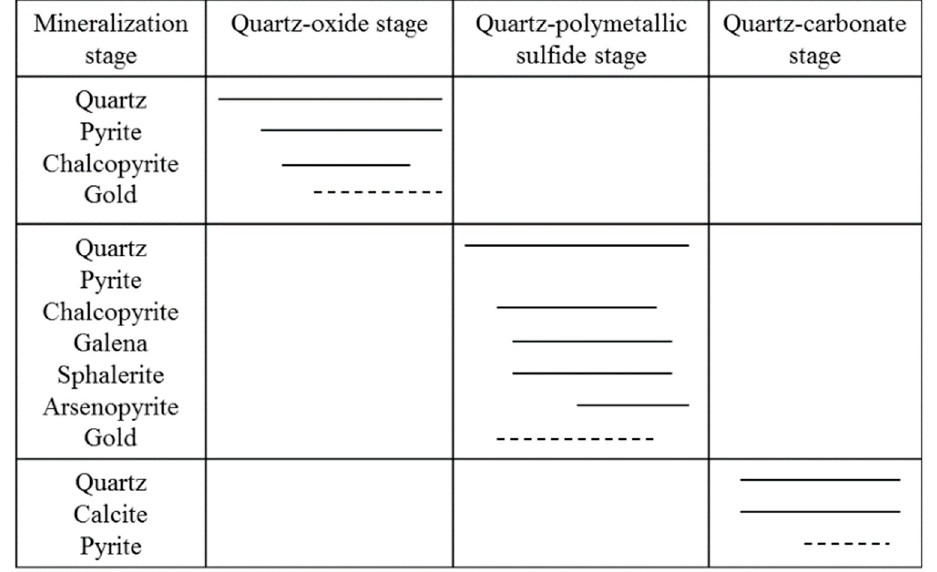
Figure 3. Paragenetic sequence of ore minerals and the main ore stages of Laowan gold deposit (adapted from [55]). Solid lines indicate a high amount of the mineral and the dotted lines indicate a small amount of the mineral.